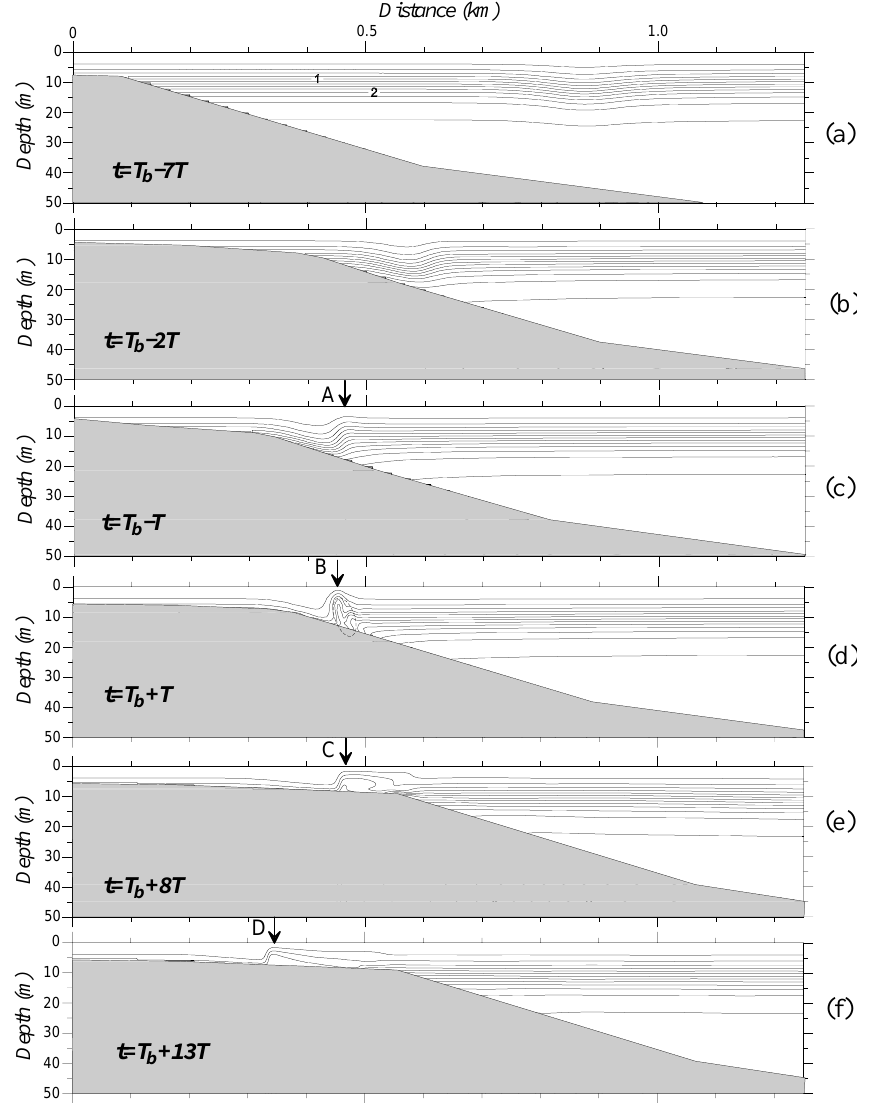
Fig. 12. Interaction of small amplitude internal wave ( a m = 2m) with lake boundary. All designations are the same as in Fig. 8, except the time scale. Here, T = 330s. Thick arrows marked by letters A–D show the formation of an upsloping, propagating